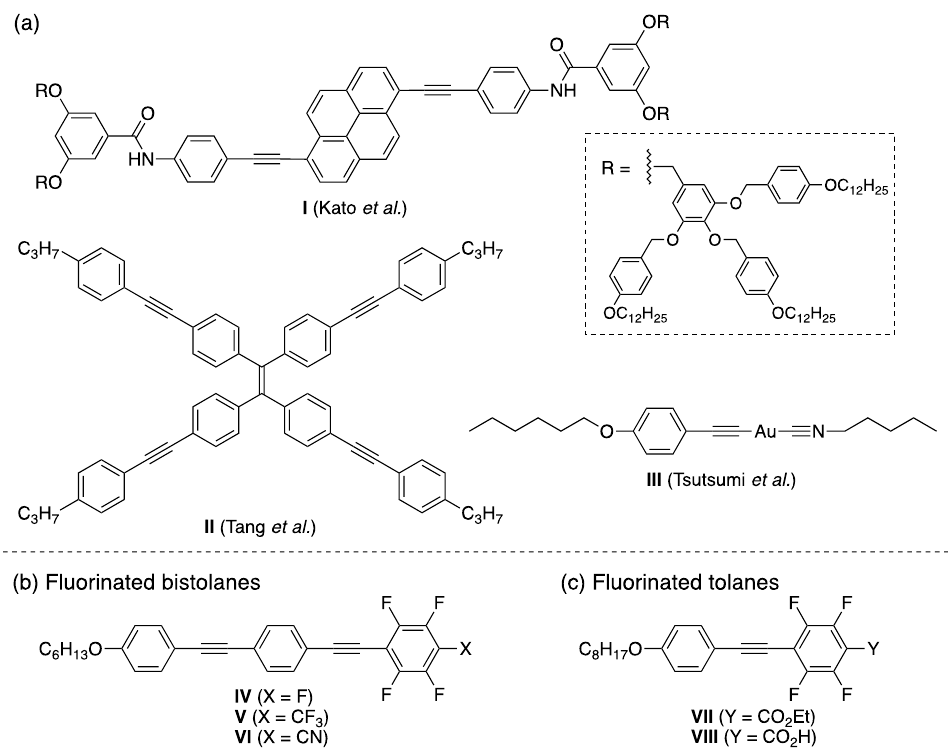
Figure 1. Chemical structures of ( a ) PLLC molecules I – III obtained from the literature [11 – 13] and ( b ) fluorinated bistolane-type PLLCs IV – VI [14,15] and ( c ) fluorinated tolane-type PLLCs VII and VIII developed by our group [16,17].